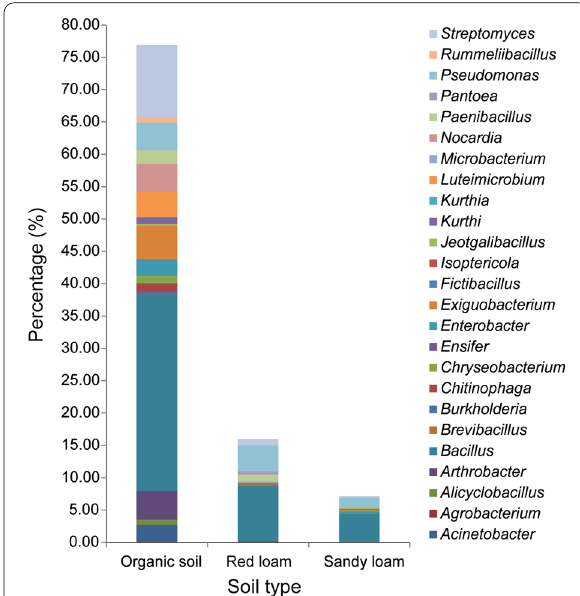
Fig. 2 Richness and percentage of endophytes of maize seedlings in different